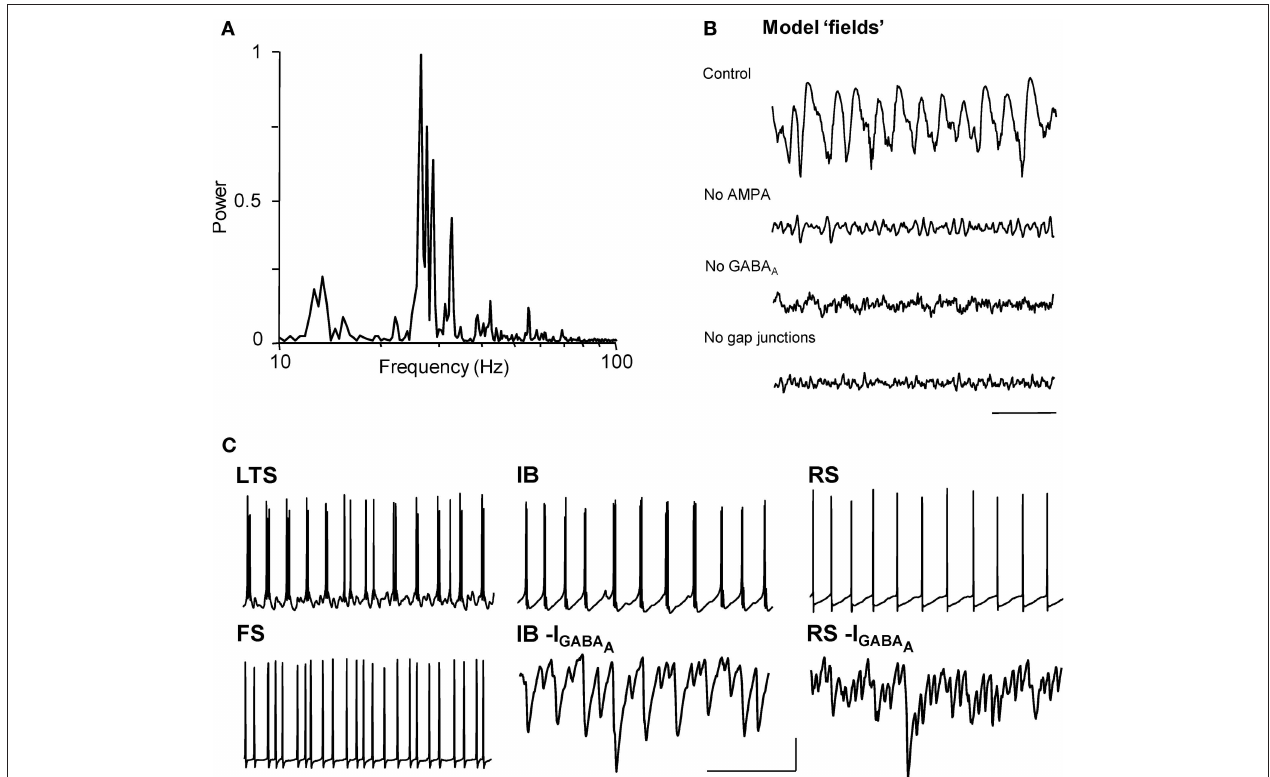
FiGurE  | Model predicts synaptic connectivity between layer V pyramidal cells and gap junctionally coupled LTS cells is necessary and sufficient for cholinergic beta rhythm generation. (A) Model ‘field’ potential (mean synaptic activity) spectrum from excited, interconnected IB, RS, FS and LTS cell network shows a prominent beta2 frequency peak. (B) The pharmacology of model beta2 rhythms is the same as that in experiment (cf. Figure  ). Scale bar